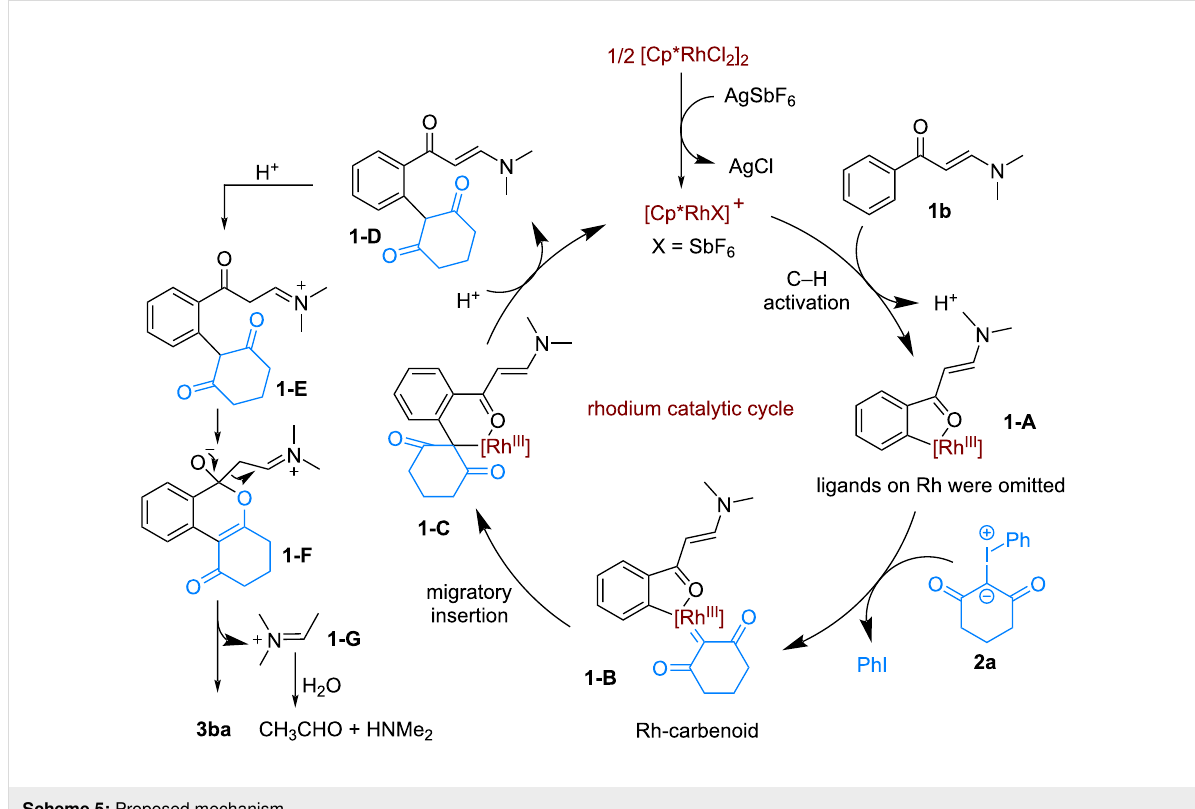
Scheme 5: Proposed